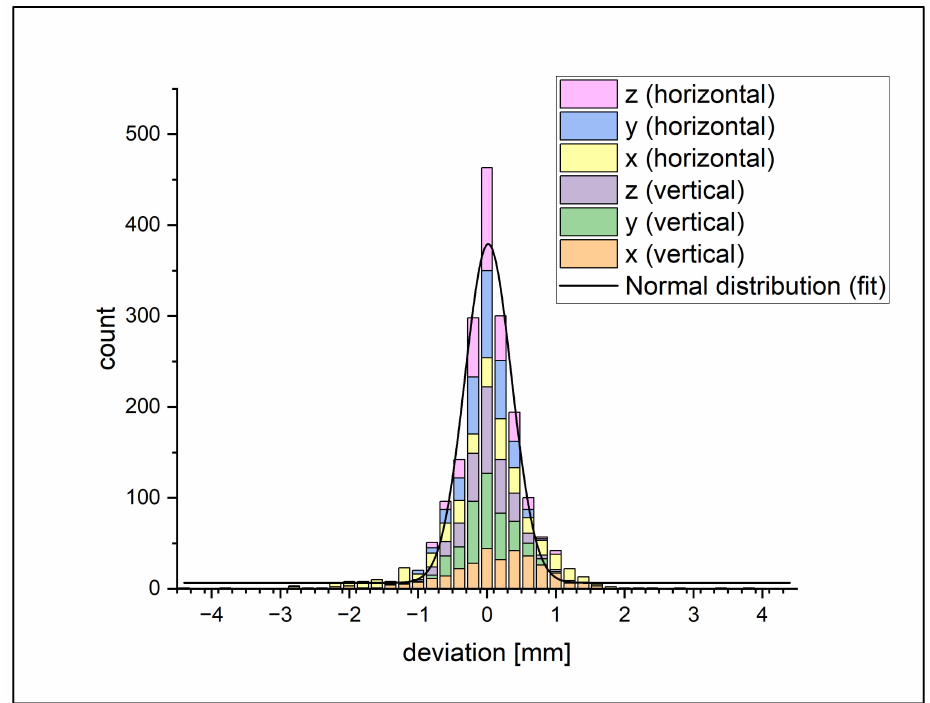
Figure 7. Histograms of the deviation between the feature points on the 3D model and the tagged position on the X-ray image. It shows the counts for a range of 0.2 mm. The colors show the results for each axis on the horizontal and vertical